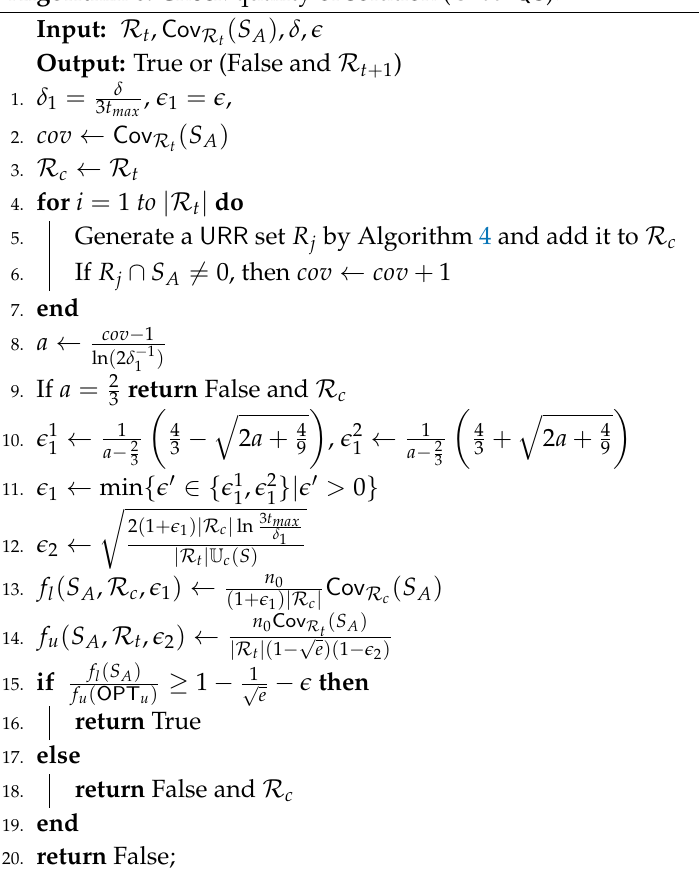
Algorithm 6: Check quality of solution ( CheckQS